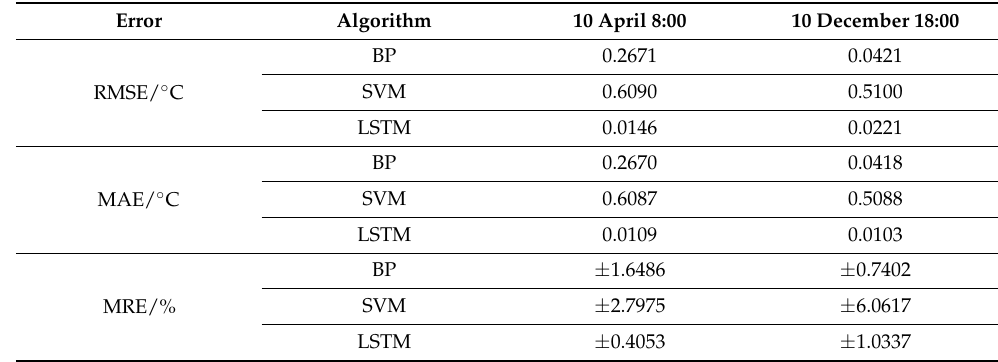
Table 2. The error comparison of the different prediction